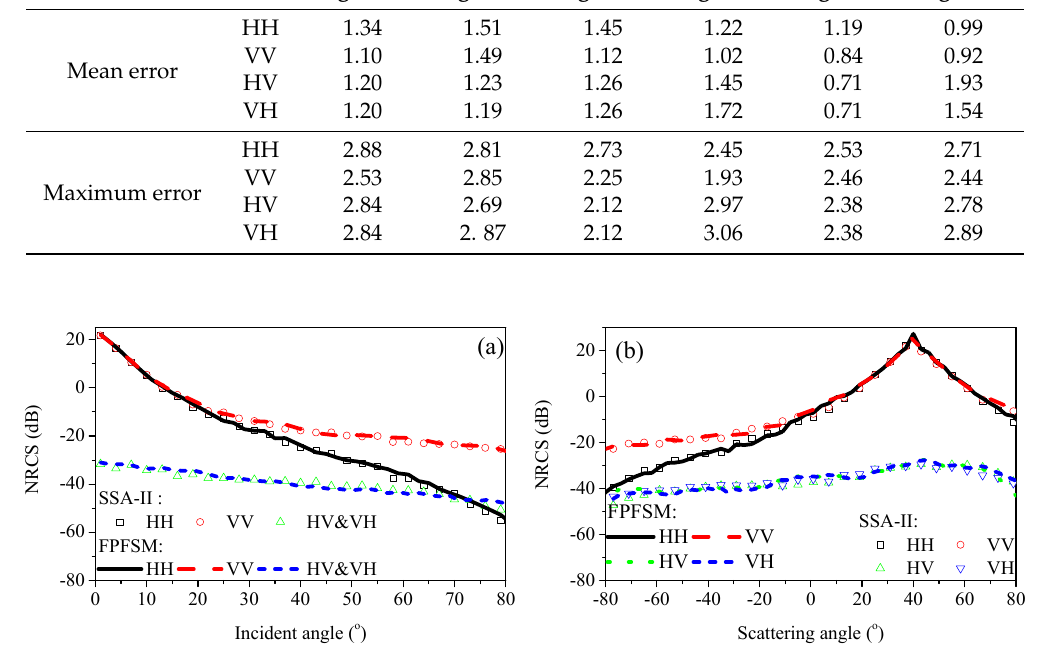
Figure 6. Comparison of the NRCS results calculated by FPFSM and SSA-II at L-band. ( a ) Monostatic configuration; ( b ) Forward–backward configuration.